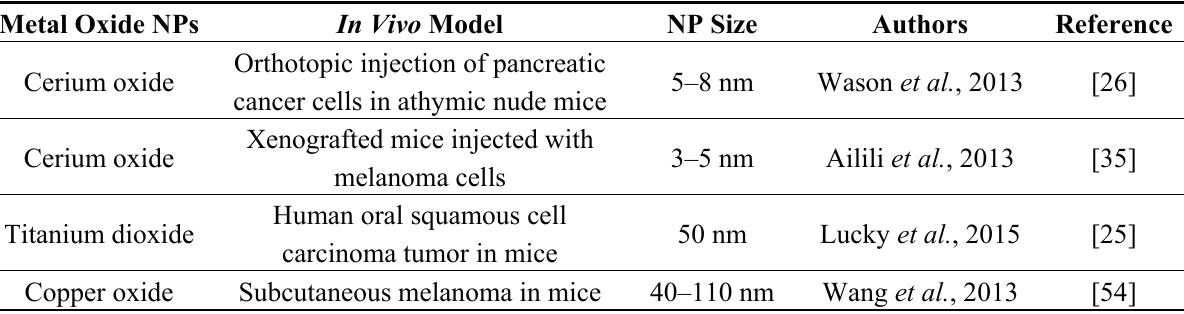
Table 1. Metal oxide NPs with anticancer activity by direct action on tumor cells in different in vivo